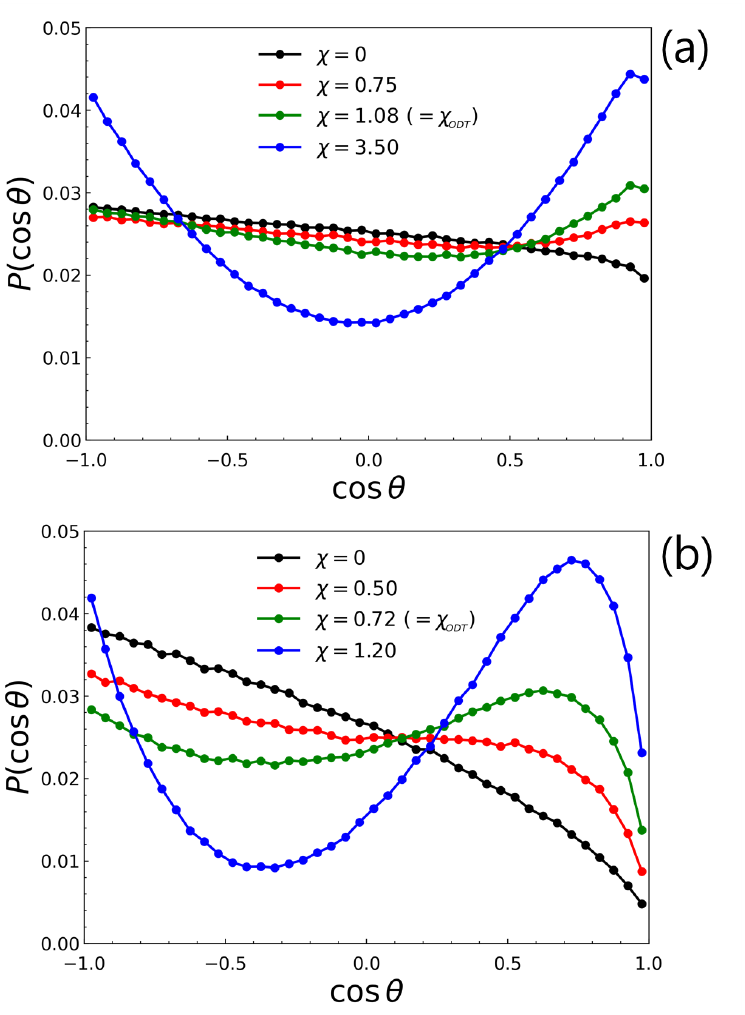
Figure 3. P ( cos θ ) for ( a ) L-TBC (i.e., N = 1) with M = 48 and for ( b ) C-TBC with M = 16 and M = 8 at various χ values. The χ ODT for ( a,b ) were χ = 1.08 and χ = 0.72, respectively. In Figure 4, the fractions of bridge conformation, Φ , measured by Equations (12) and (13), are plotted as a function of χ for various L- and C-TBC